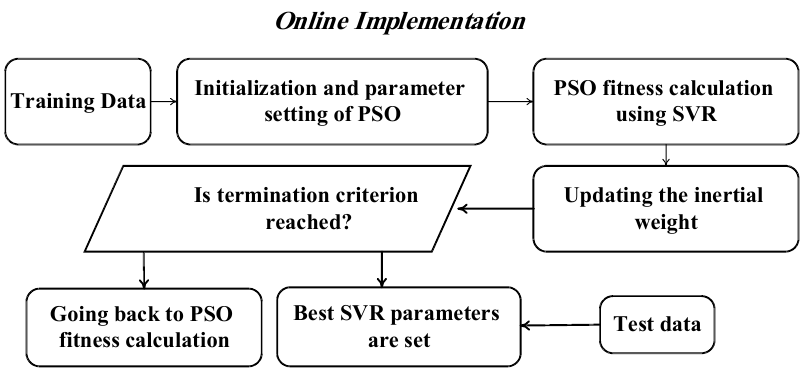
Figure 14. Implementation process diagram.